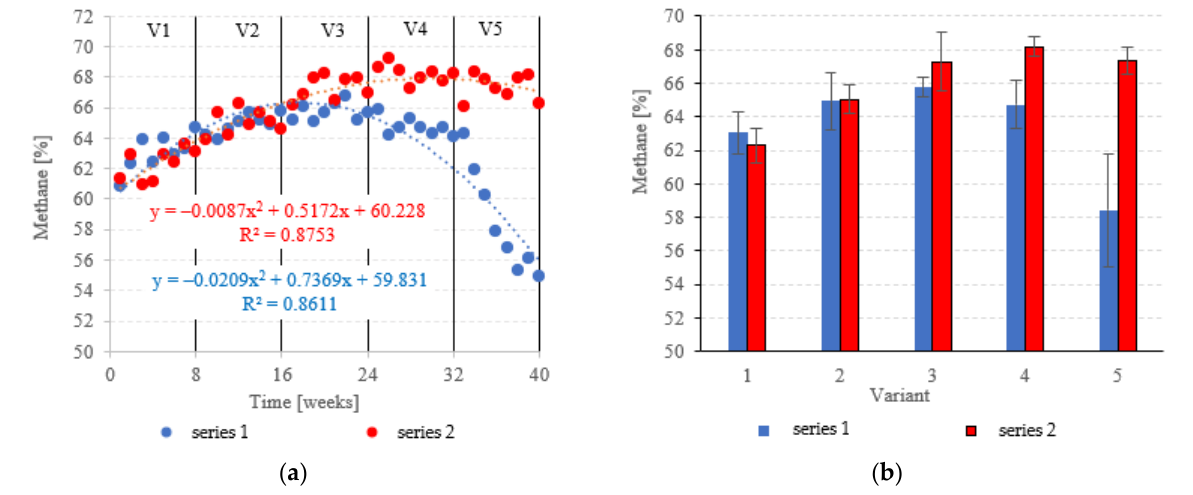
Figure 16. CH 4 content (( a ) changes throughout the experiment; ( b ) average across experimental variants).